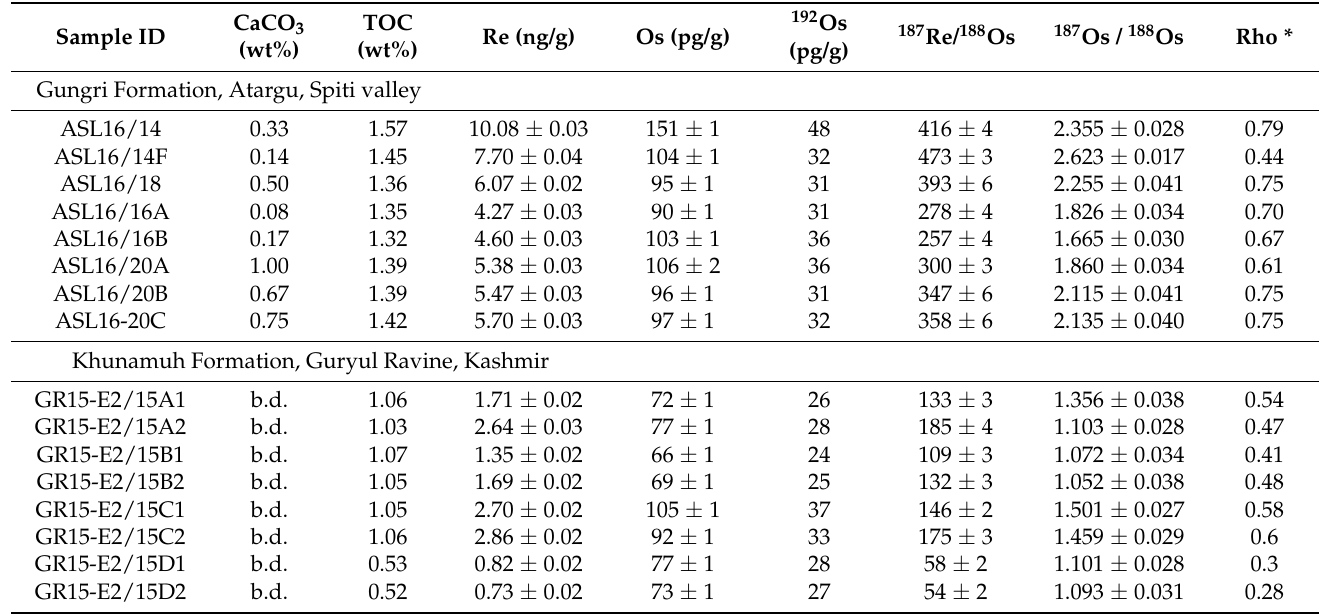
Table 1. Geochemical and Re–Os isotopic data for the Late Permian rocks from two Himalayan sedimentary sections (Kashmir and Spiti valley,